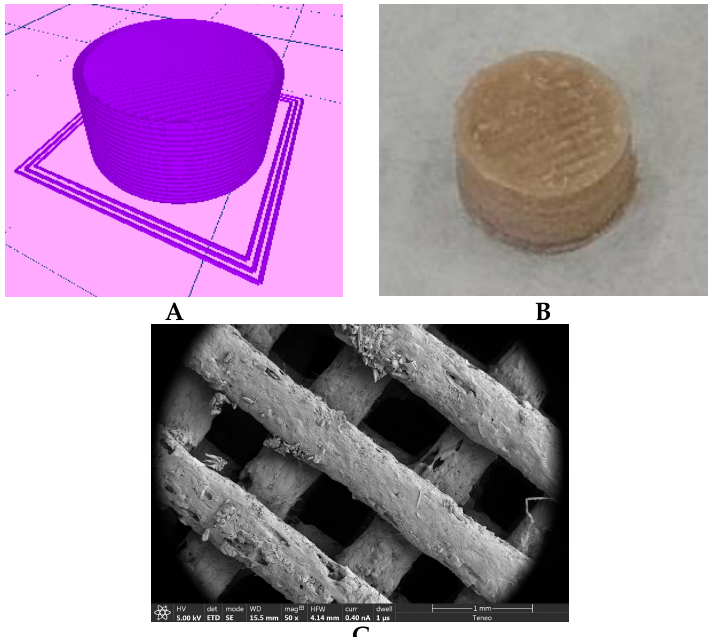
Figure 6. ( A ) Digital design of 3D-printed systems, showing the top solid layer and the perimeter. ( B ) 3D-printed systems made with a 30A filament. ( C ) SEM image, magnification 50 × , of the internal mesh of a printed system made with a 40A filament.